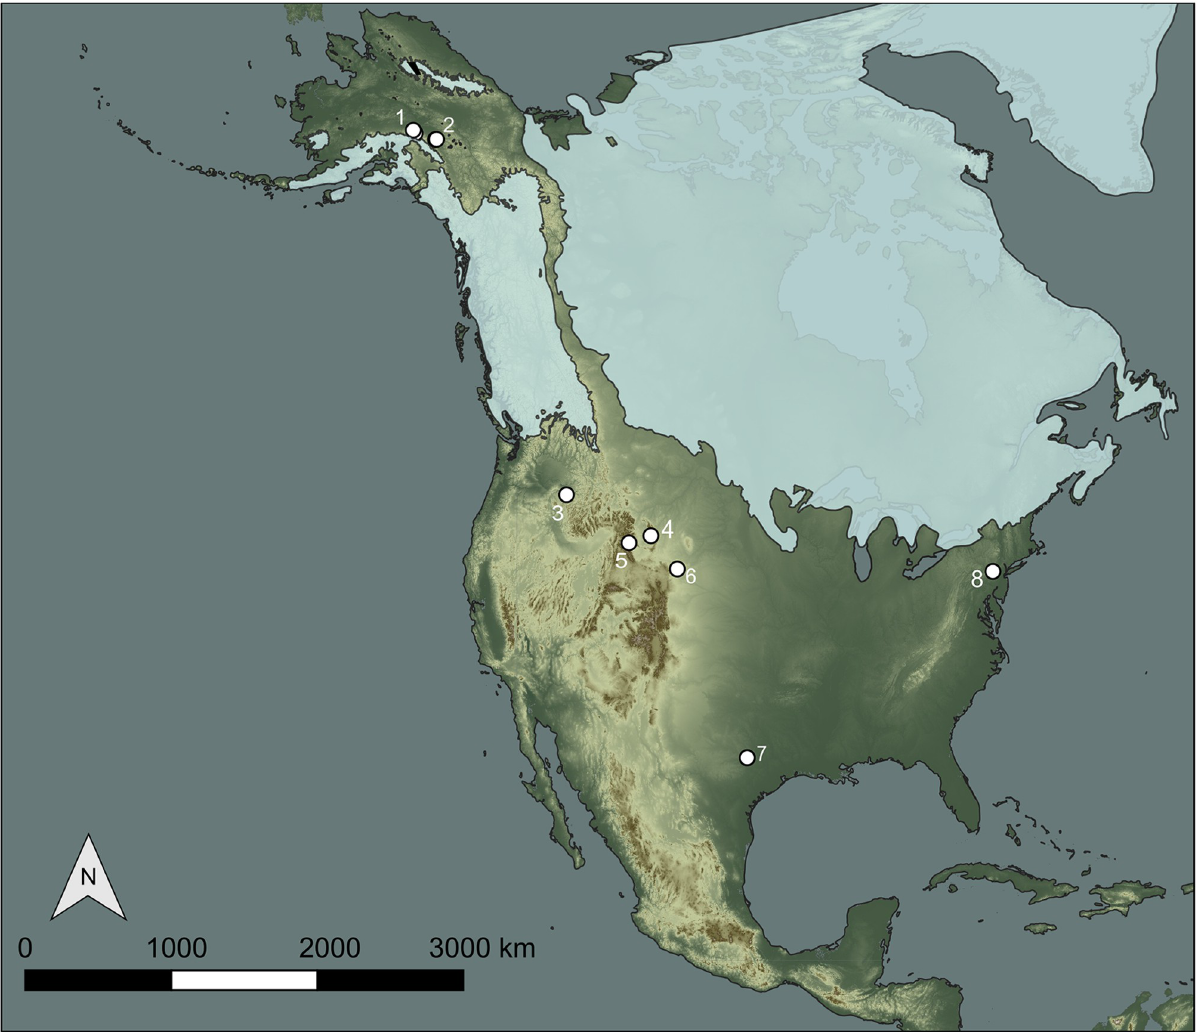
Fig 4. Map of sites used in this study. (1) Dry Creek and Owl Ridge, (2) Holzman South, Swan Point, and Broken Mammoth, (3) Cooper’s Ferry, (4) Alm Shelter; (5) Helen Lookingbill; (6) Hell Gap; (7) Gault and Debra L. Friedkin, (8) Shawnee-Minisink. Light blue polygons show the estimated extent of the continental ice sheets at 14,900 BP from Dalton et al. [57]. Digital elevation model of North America is from the USGS Global Multi- resolution Terrain Elevation Dataset